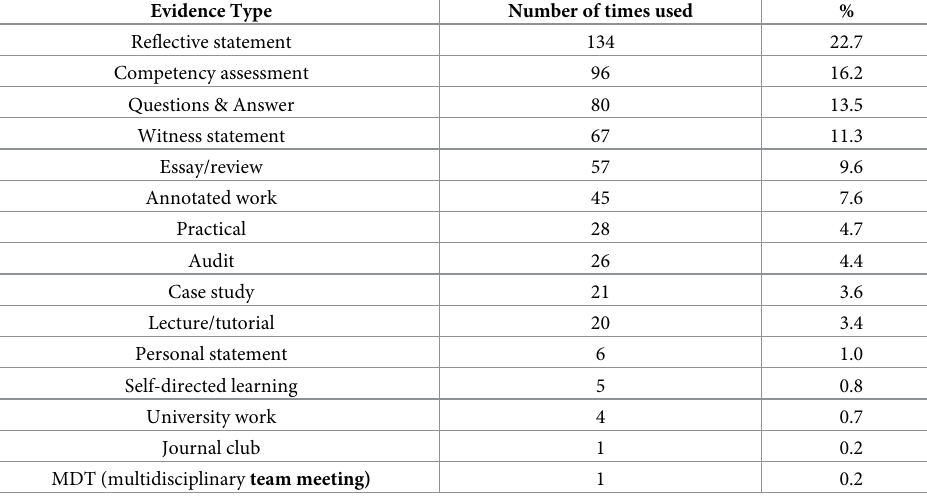
Table 4. Types of evidence used by United Kingdom clinical laboratories to meet requirements for health and care professions council standards of proficiency 14.16 and